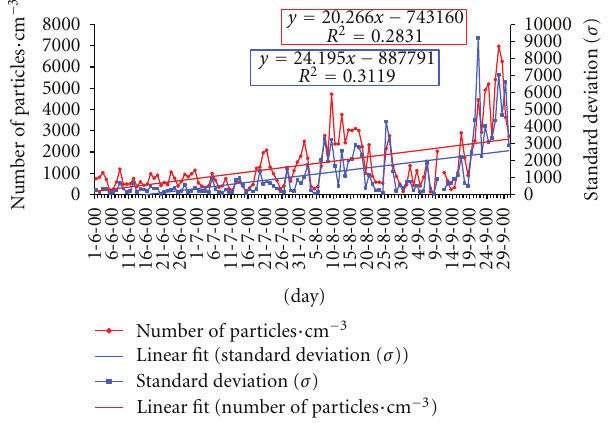
Figure 5: Average number of particles and standard deviation in the months of June, July, August, and September